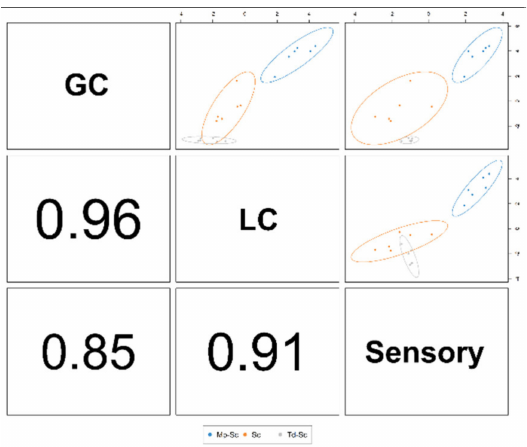
Figure 7. Pearson correlation plot obtained from the sparse generalised canonical correlation analysis discriminant analysis (sGCC-DA) model.